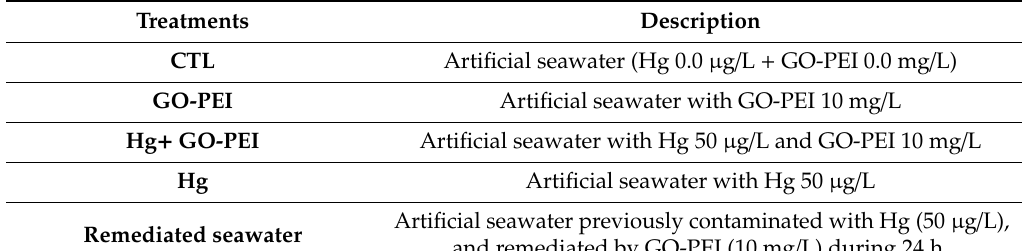
Table 1. Experimental treatments. GO-PEI: Graphene oxide functionalized with polythyleneimine; Hg: